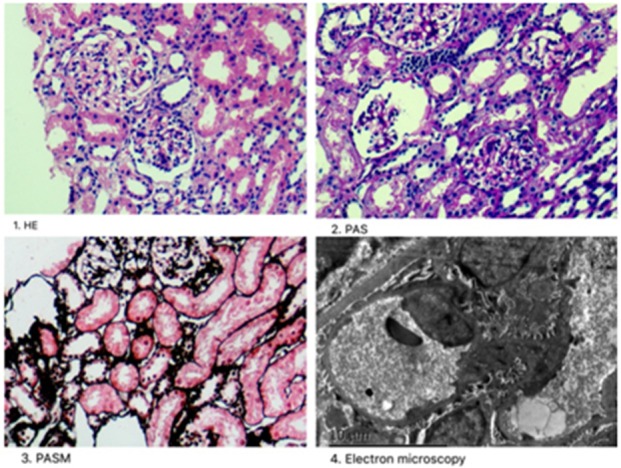
Renal histopathological features in Patient 1. (1) Mesangial cells (2–4 mesangial area) proliferation was shown by hematoxylin-eosin stain (×400); (2) One glomeruli was globally sclerotic shown by Periodic acid–Schiff stain (×400). (3) Inflammatory cell infiltration around the renal interstitium shown by periodic acid-silver metheramine stain; (4) Electron microscopy revealed mild mesangial proliferation with less electron dense deposits.